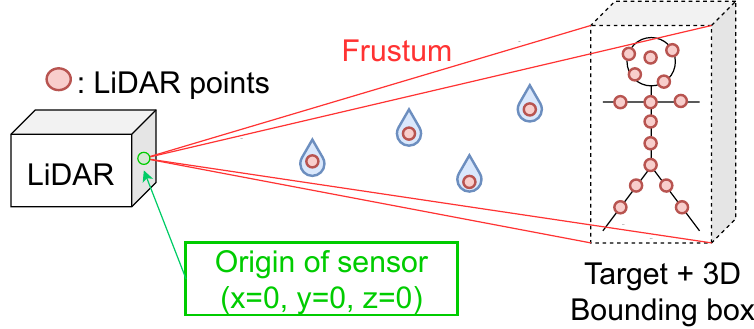
Figure 9. Schematic diagram of a lidar frustum in a DVE situation.